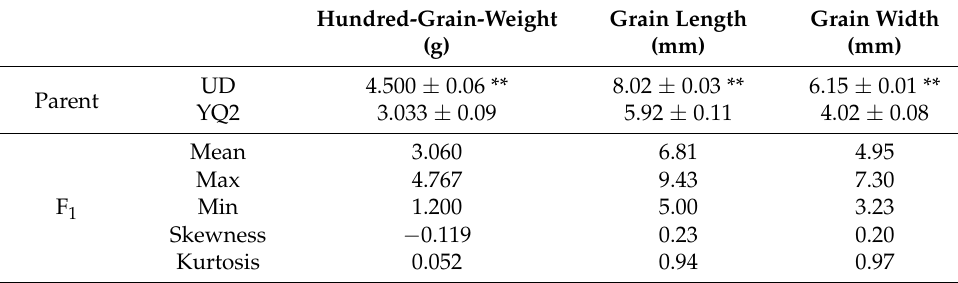
Table 1. Phenotypic data analysis of grain size traits for the parents and F 1 populations.